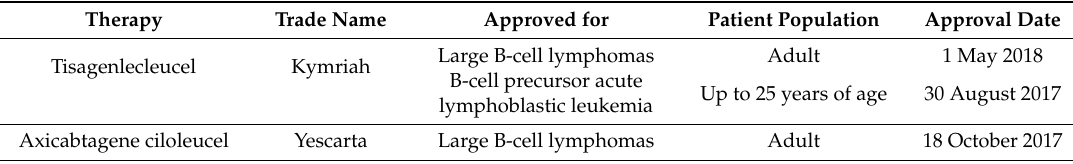
Figure 1. The basics of CAR-T therapy. The first step in CAR-T therapy is the collection of blood from the patient, for the harvesting of T-cells, which are then transduced with the appropriate gene to create ‘CAR-T cells’. These engineered cells are then propagated in the laboratories, to reach a titer that can be effective when infused back in the same individual from whom the T-cells were harvested. Infusion is often preceded by lymphodepletion a-few-days-to-a-week prior. Table 1. FDA approved CAR-T Table 1. FDA approved CAR-T therapies.